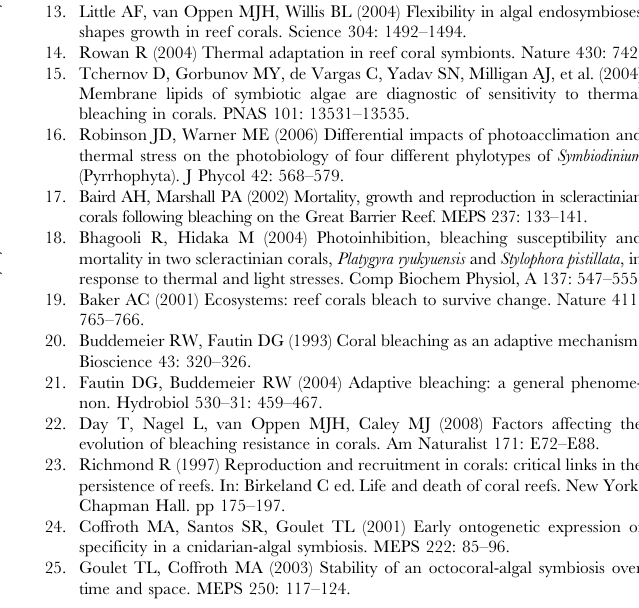
Found at: doi:10.1371/journal.pone.0006364.s002 (0.03 MB Found at: doi:10.1371/journal.pone.0006364.s003 (0.05 MB Supporting Materials and Methods S1